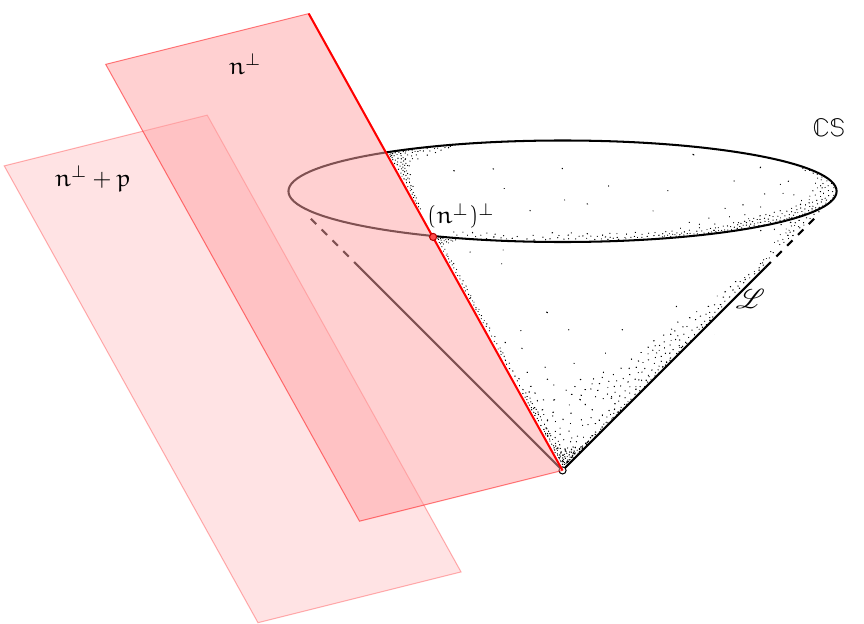
Figure 6 . Fibering of Ni over both the future-pointing lightcone and the space of affine null